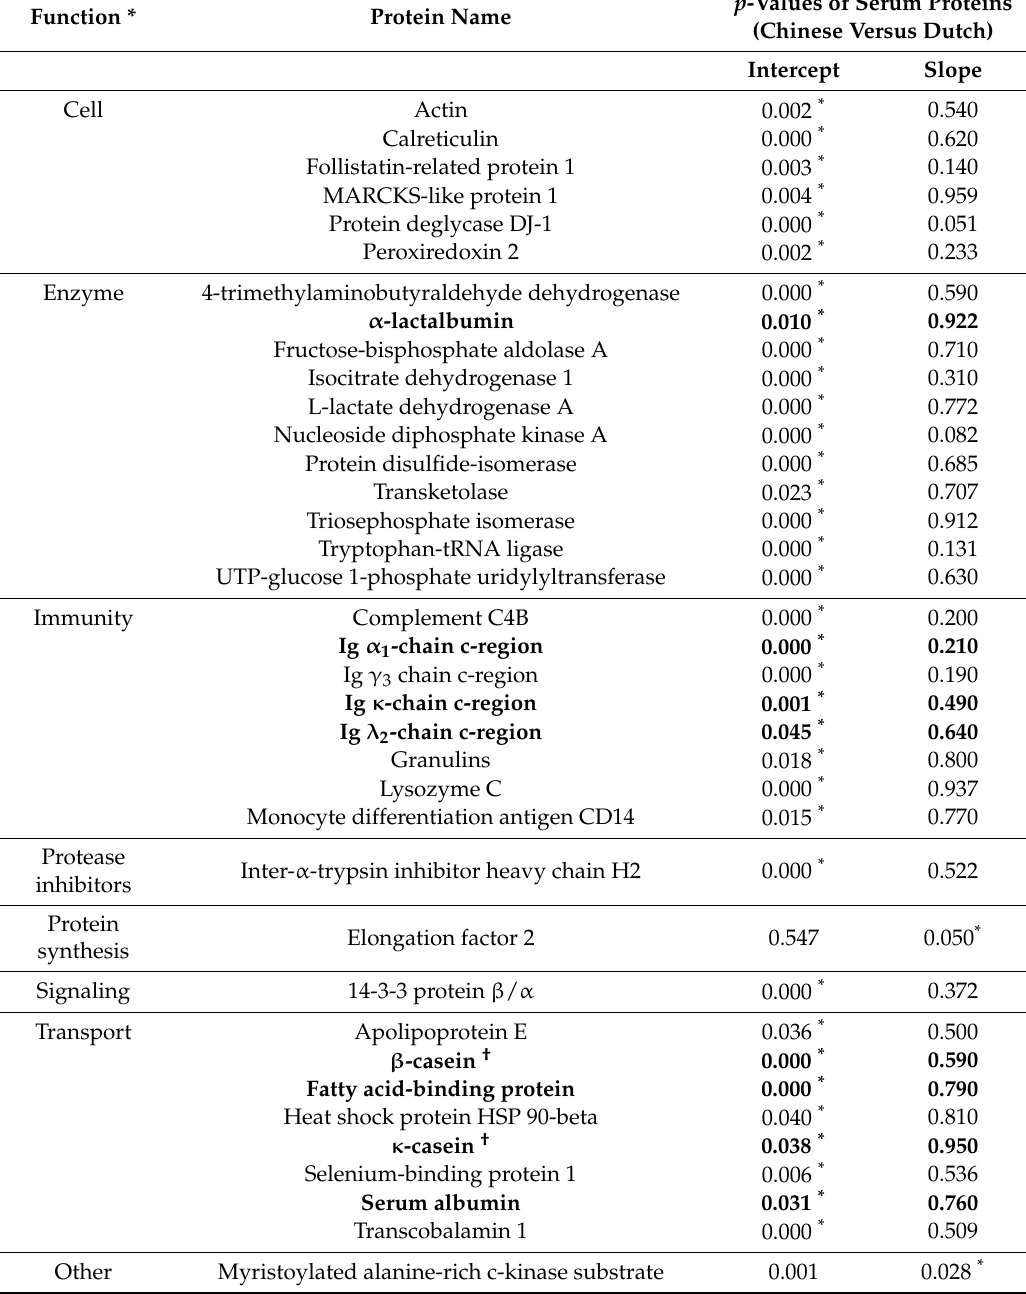
Table 2. Significantly different serum proteins in Chinese and Dutch human milk, with p -values for week 1 (intercept) and over the course of lactation